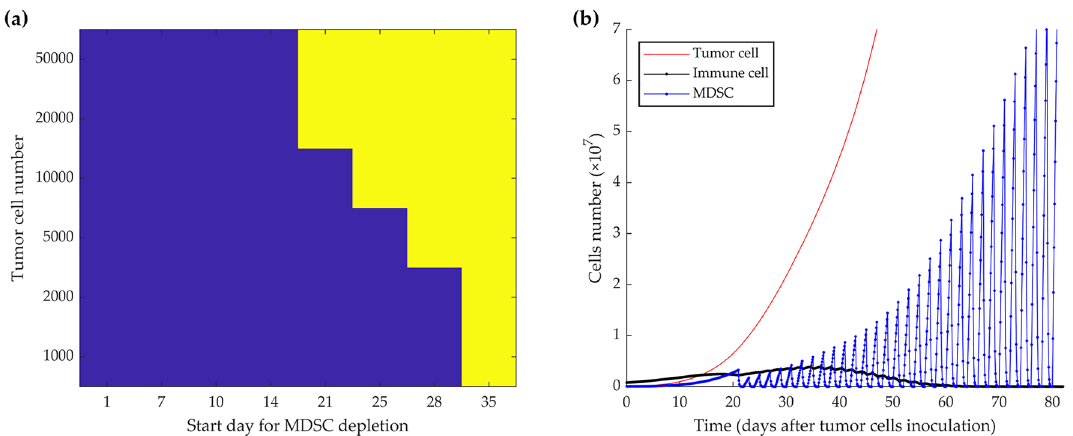
Figure 4. Simulation of MDSC-depletion from tumor-bearing mice every 2 days for 2 months with different starting days after tumor cell injection. Different start points impact cell fates according to the different initial tumor sizes ( a ). Color-coded events: blue, tumor dormancy; yellow, tumor growth. MDSC depletion from day 21 after 5 × 10 4 tumor cells inoculation could not control the tumor growth ( b